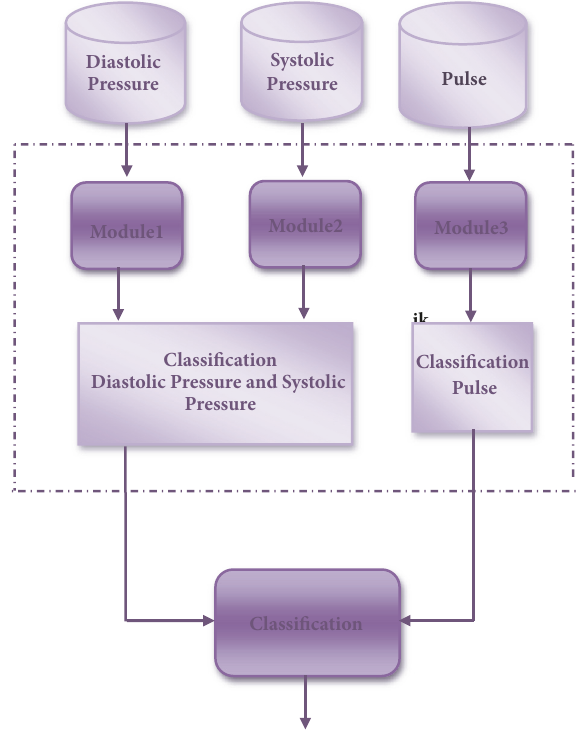
Figure 1: General scheme of the